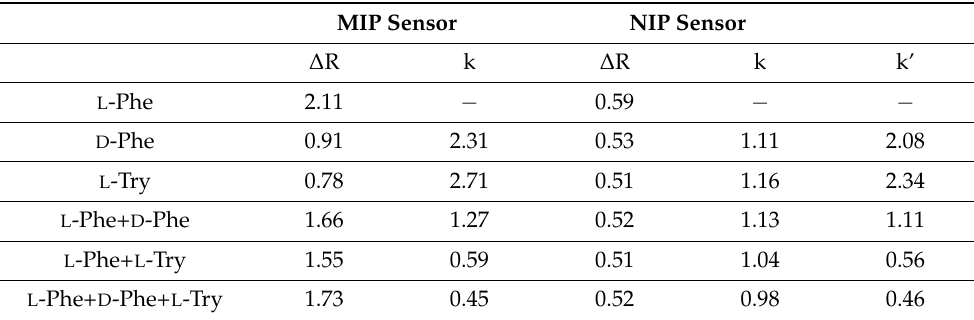
Figure 7. The selectivity studies and comparison of selectivity of SPR sensors (C: 50 µ M in all measurements). Table 2. The selectivity and relative selectivity coefficients for competitive molecules for surface plasmon resonance (SPR)